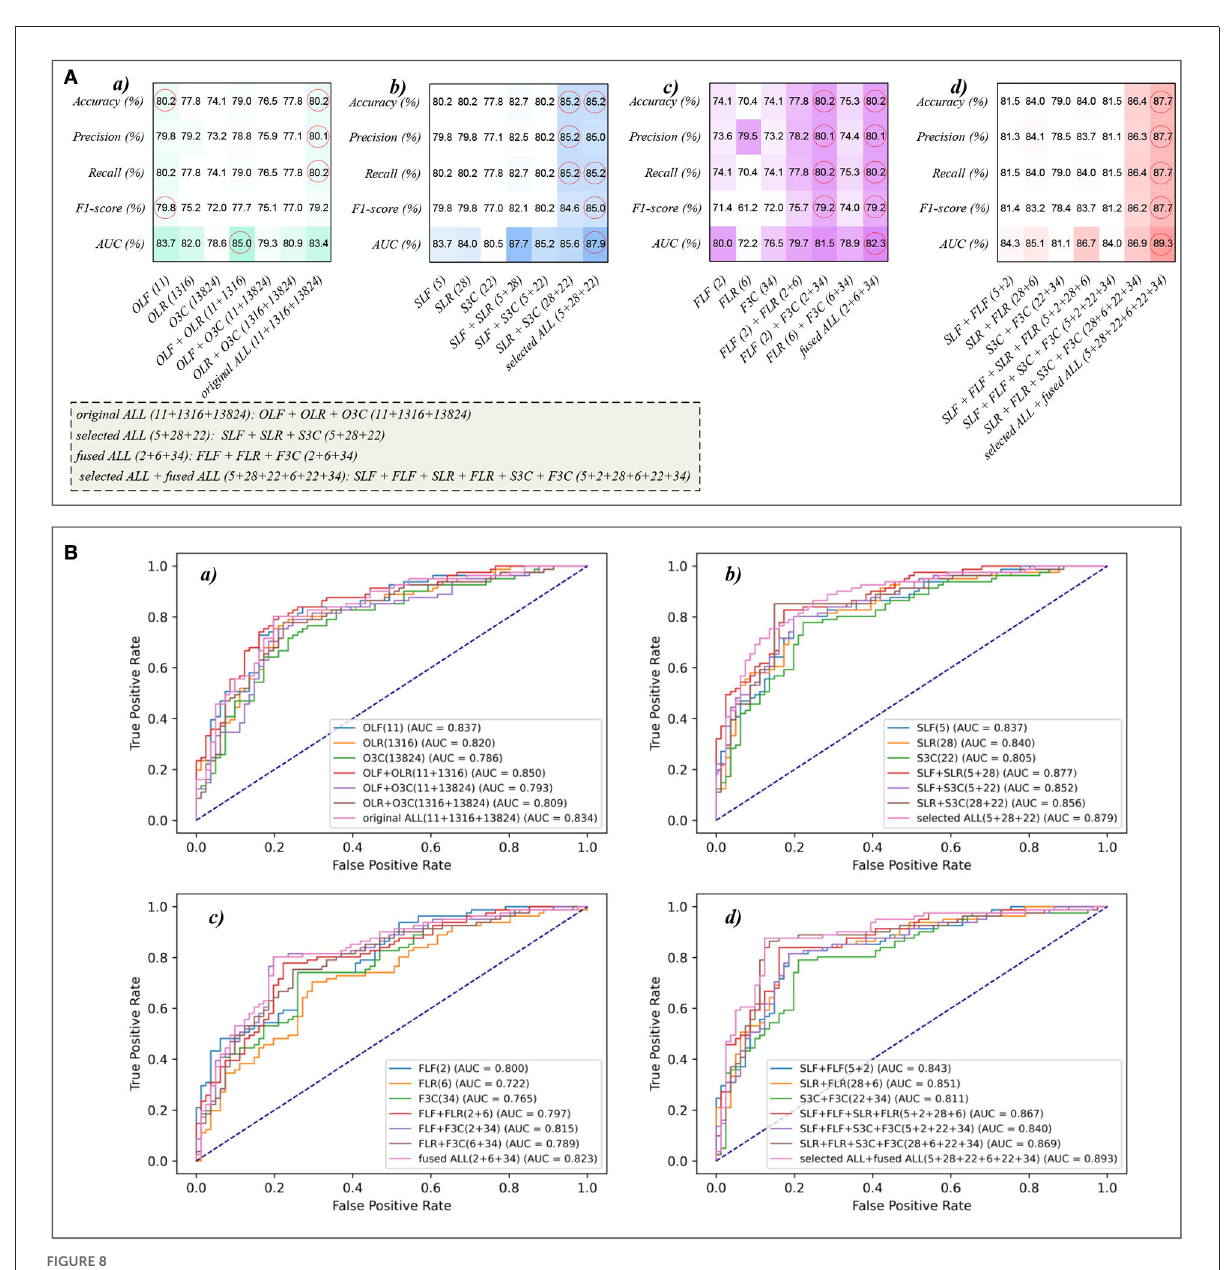
FIGURE8 The evaluation metrics pictures and ROCs of MLP classifiers with different features. (A) The evaluation metrics pictures of MLP classifiers in (a) Experiment 1, (b) Experiment 2, (c) Experiment 3, and (d) Experiment 4; (B) ROCs of MLP classifiers in (a) Experiment 1, (b) Experiment 2, (c) Experiment 3, and (d) Experiment